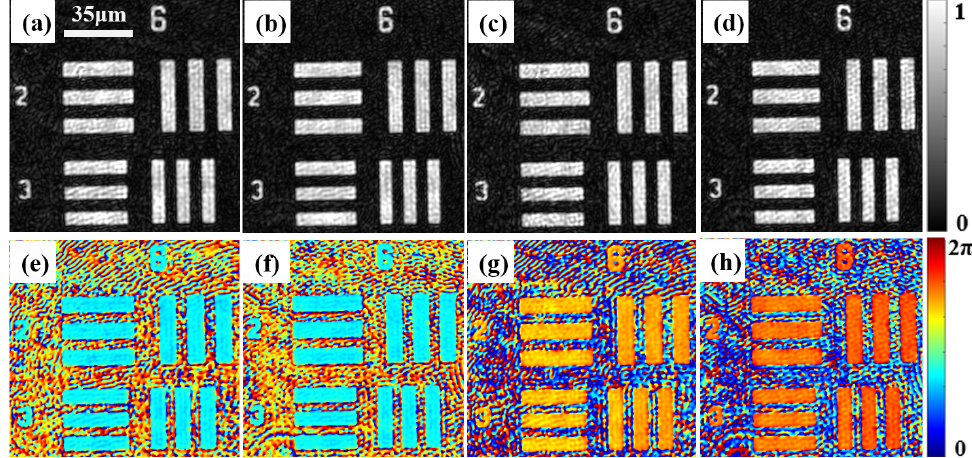
Figure 3. Amplitude and phase distributions of USAF 1951 resolution test target in two orthogonal polarization directions. ( a – d ) The amplitude distributions corresponding to Y 11 , Y 12 , Y 21 , and Y 22 , respectively; ( e – h ) are the corresponding phase distribution.